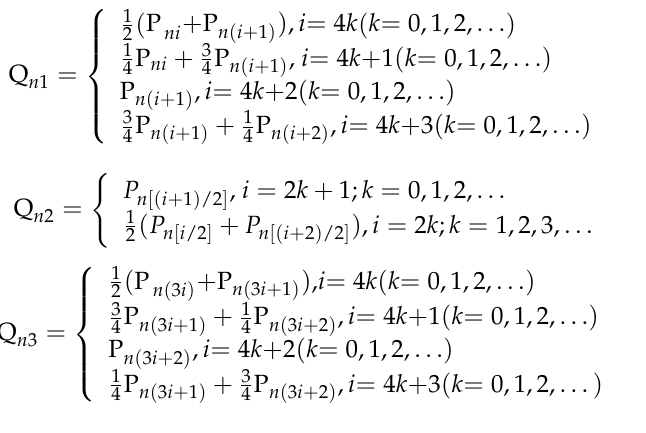
According to the data size in the power set, the set P ni is rearranged in ascending